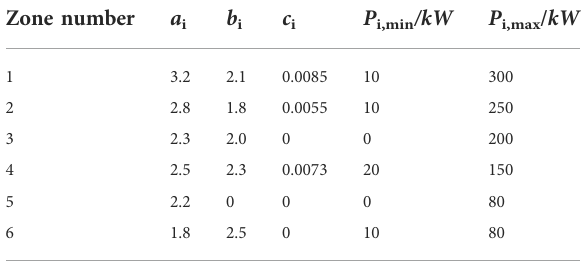
TABLE 2 Cost parameters and generation